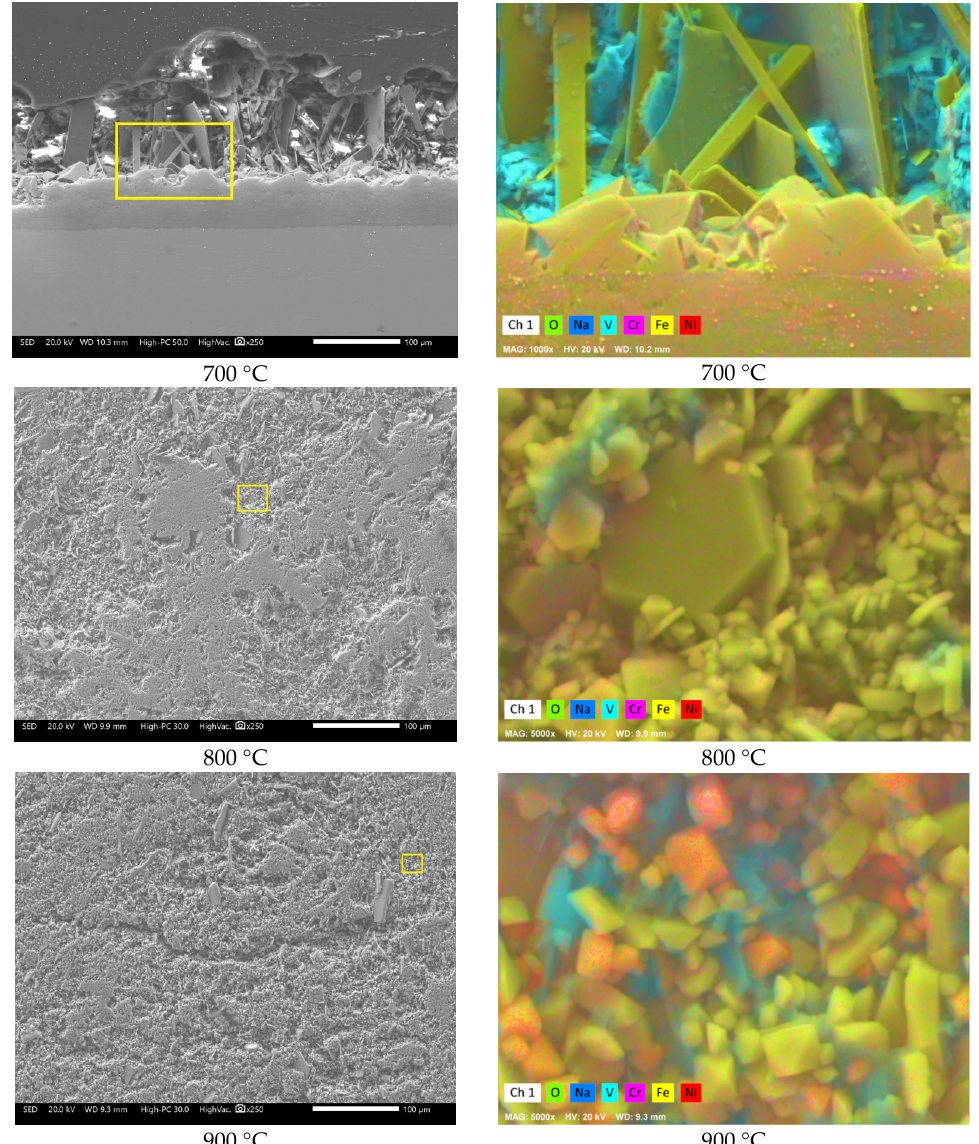
Figure 15. Approach to the corrosion-product layer and element mapping of 304H corroded steel in NaVO 3 at 700, 800, and 900 °C after 100 h. The box indicates the area where the element mapping was NaVO 3 at 700, 800, and 900 ◦ C after 100 h. The box indicates the area where the element mapping performed. was